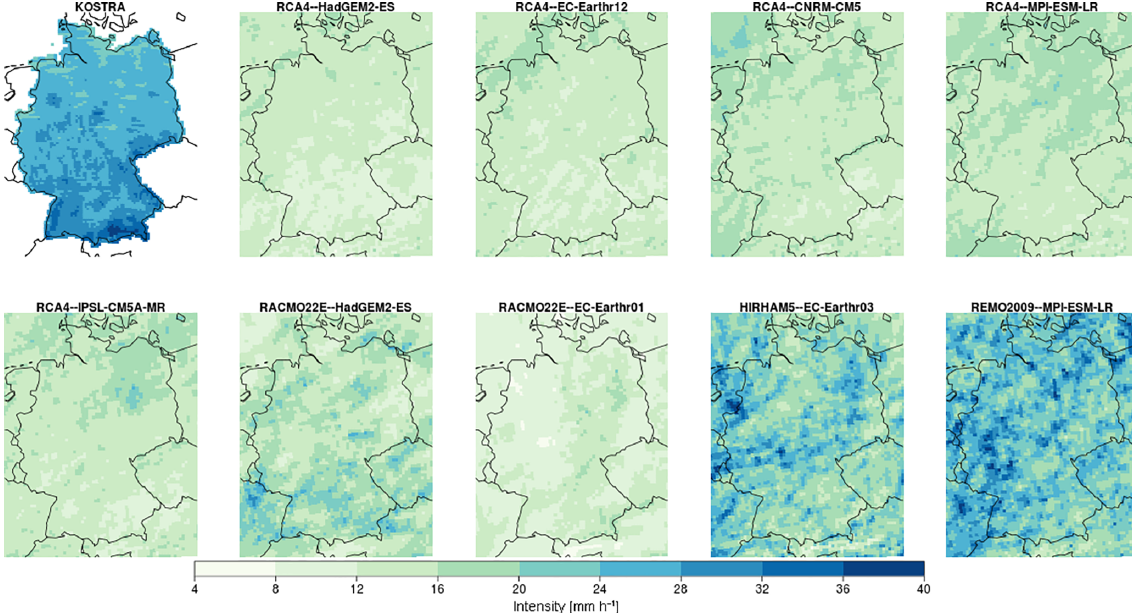
Figure 2. Intensity for 10-year return period for 1h duration of KOSTRA and all models in the RCM ensemble for